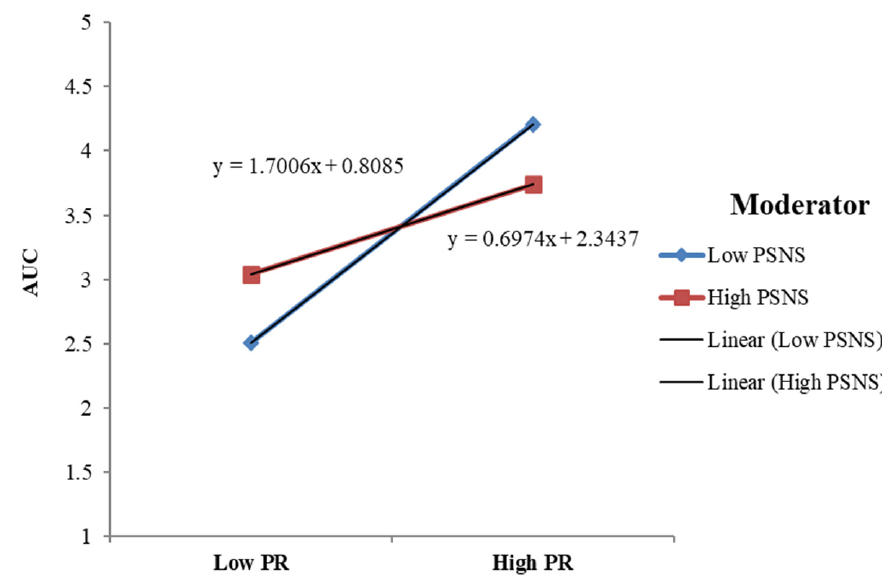
Figure 3. PSNS’s high and low effects on AUC through PR.